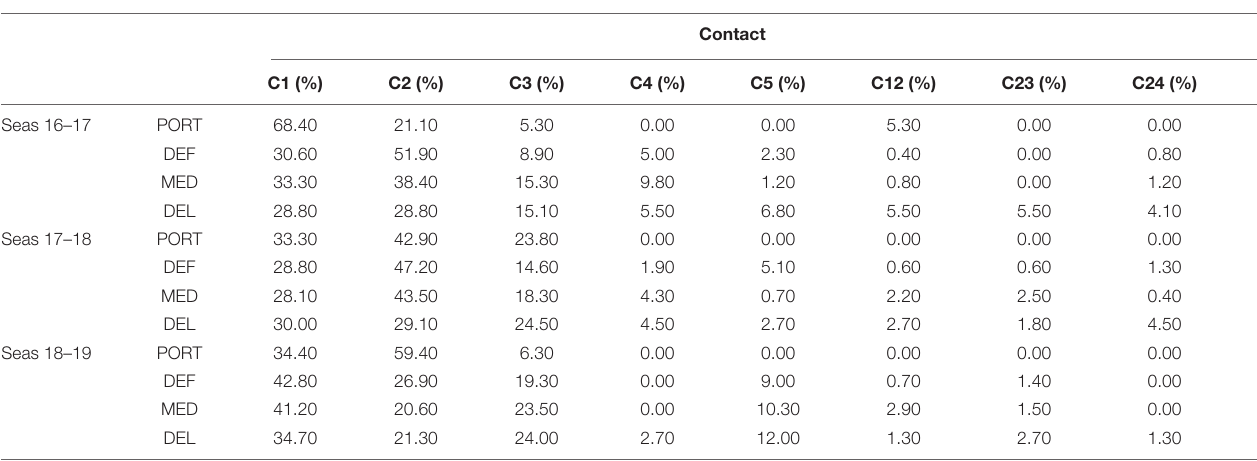
TABLE 11 | Contingency table: Season * Demarcation * Type of contact.